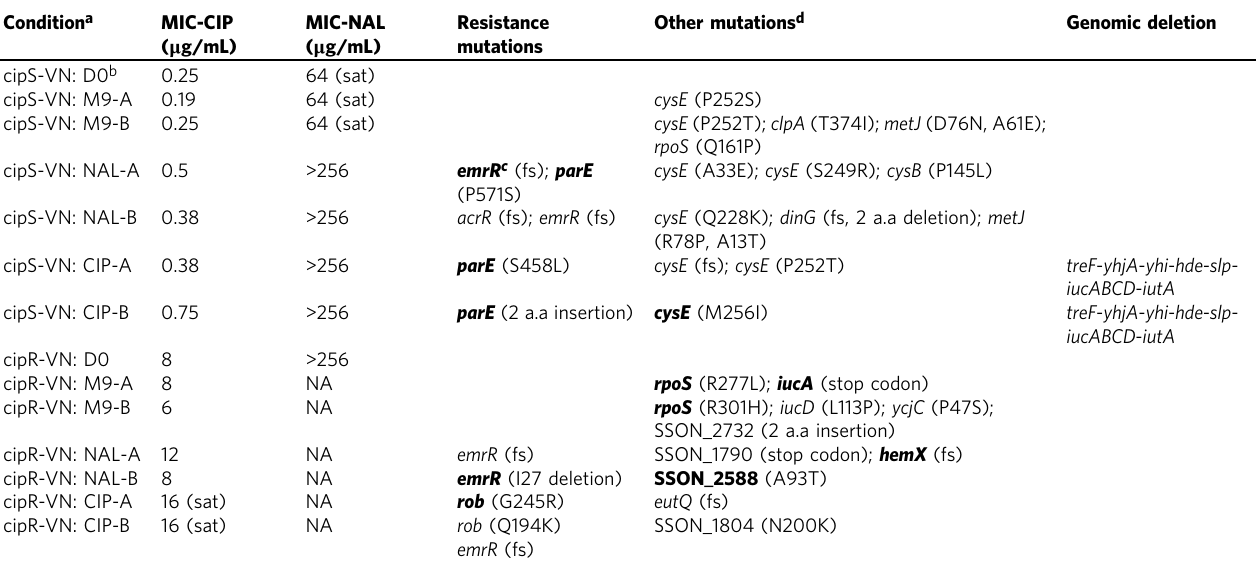
Table 3 Results of antimicrobial susceptibility and mutation analysis of experimental evolution in Shigella sonnei Condition